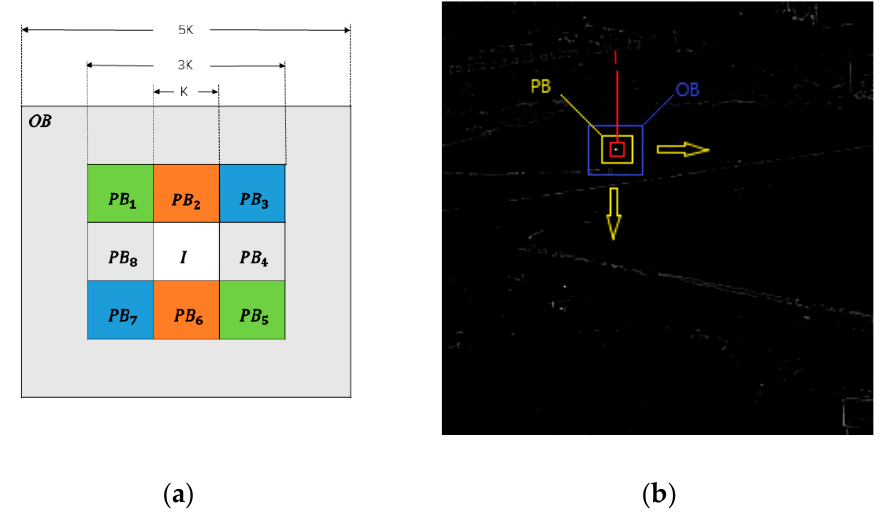
Figure 3. ( a ) The nested structure of the tri-layer window. ( b ) Regions of the tri-layer window.